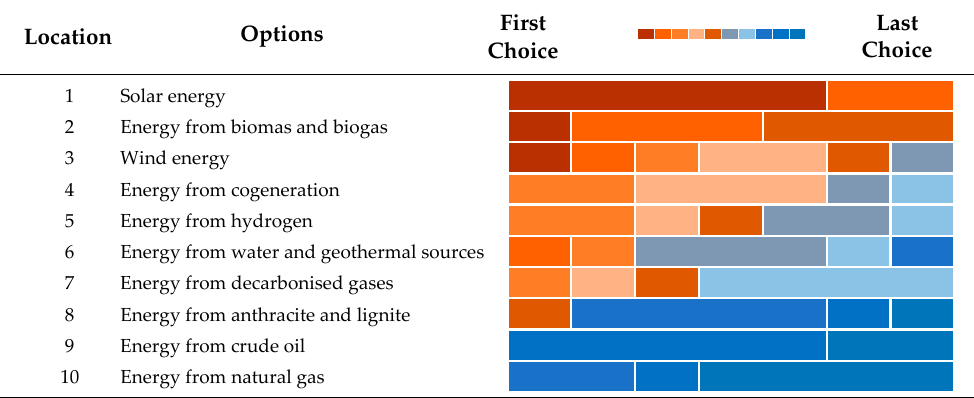
Table 3. Priorities of financial, legal, and organizational support for the development of energy sources in the macroregion of Eastern Poland in the perspective of 2030.